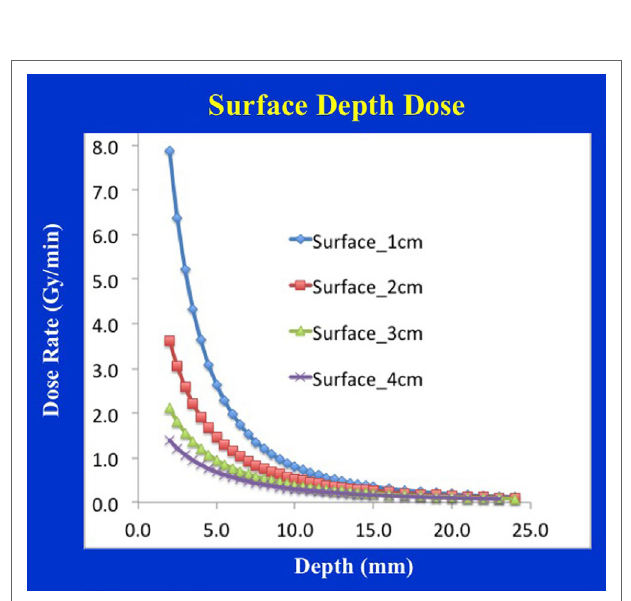
FigUre 10 | Surface applicator depth-dose (DD) profiles for a range of diameters (1–4 cm). Larger applicators are characterized by superior dose homogeneity, smaller output factor, and longer treatment times. Notice a lack of measured data at shallow depths ( < 2 mm) due to the chamber design.